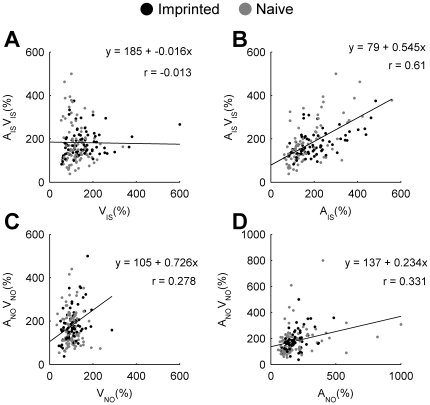
Principle of inverse effectiveness.Axes indicate the response magnitude (% of baseline activity) of individual neurons recorded from naïve (grey) and imprinted (black) chicks to unisensory (x-axis) and multisensory stimuli (y-axis). Equations and r-values indicate regression and correlation coefficients respectively. (A) Visual component (VIS) vs. audiovisual imprinting stimulus (AISVIS). (B) Auditory component (AIS) vs. audiovisual imprinting stimulus (AISVIS). (C) Visual component (VNO) vs. audiovisual novel object (ANOVNO). (D) Auditory component (ANO) vs. audiovisual novel object (ANOVNO).